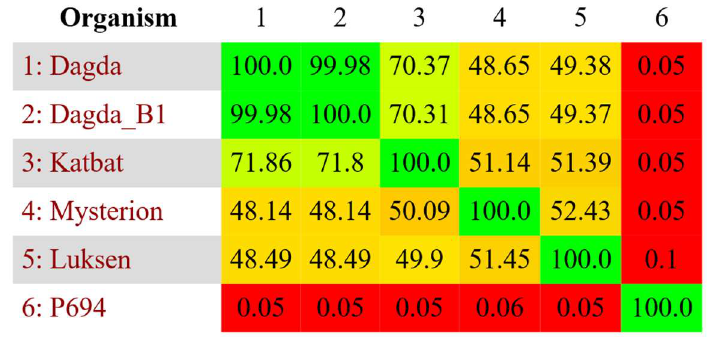
Figure 1. All vs. all nucleotide similarity analysis on all the Cluster A phages with escherichia phage P694 (KP090454) included as a reference, made using Gegenees [24].